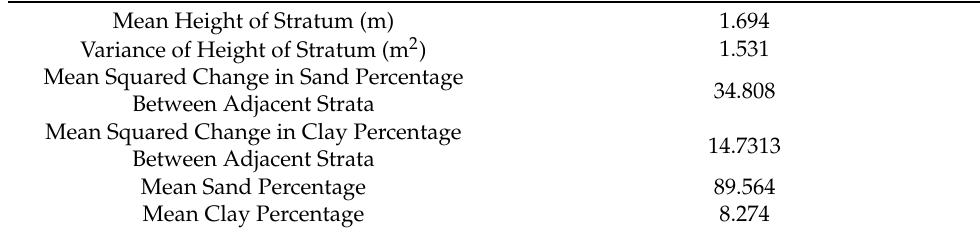
Table A1. Summary of the statistics used to simulate